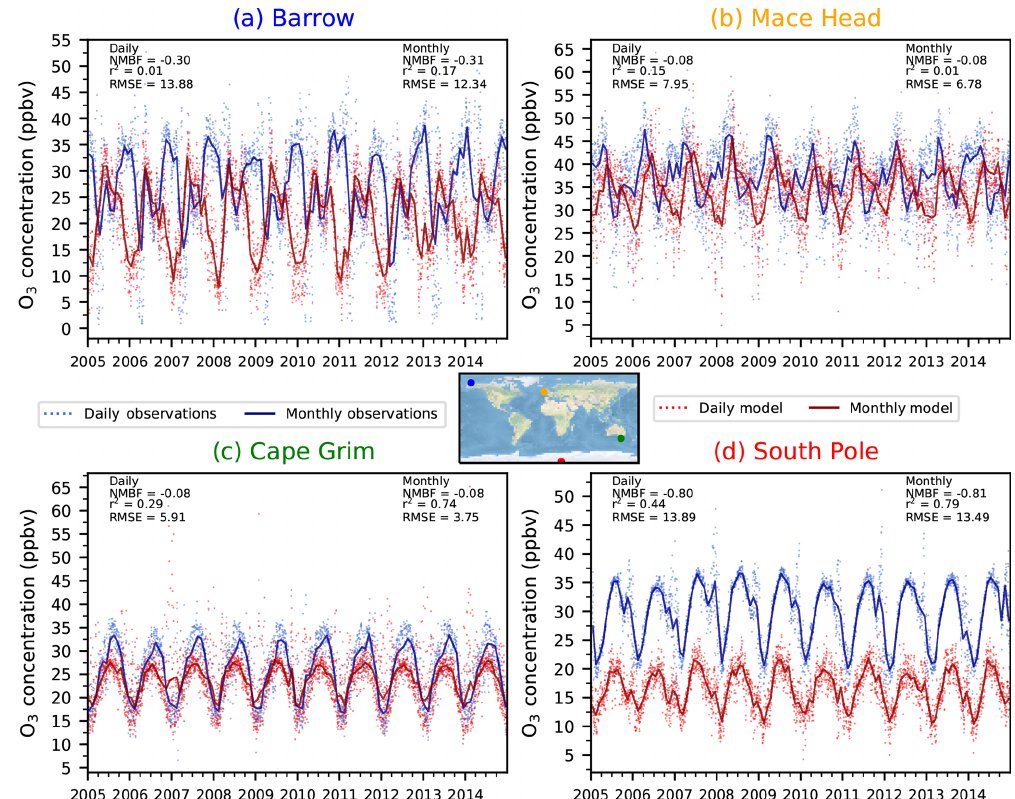
Figure 7. Simulated (ND) and observed daily and monthly mean surface O 3 over the period 2005–2014 at four individual monitoring locations of (a) Utqiagvik (formerly Barrow) (b) Mace Head, (c) Cape Grim and (d) the South